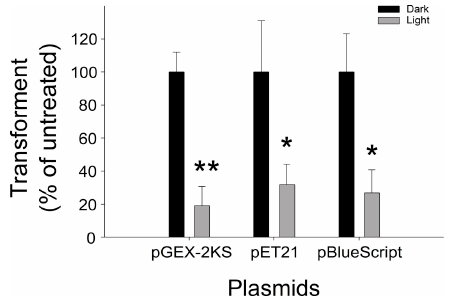
Figure 3. Significant visible light stimulated TiO 2 -Pt-mediated photocatalysis-induced DNA damage occurred in the pGEX-2KS, pET16 and pBlueScript II SK + plasmids. Notably, these plasmids all displayed similar reductions after the photocatalysis. ** p < 0.01; * p < 0.05 vs. respective dark groups. n = 6, three experiments with two replicates.